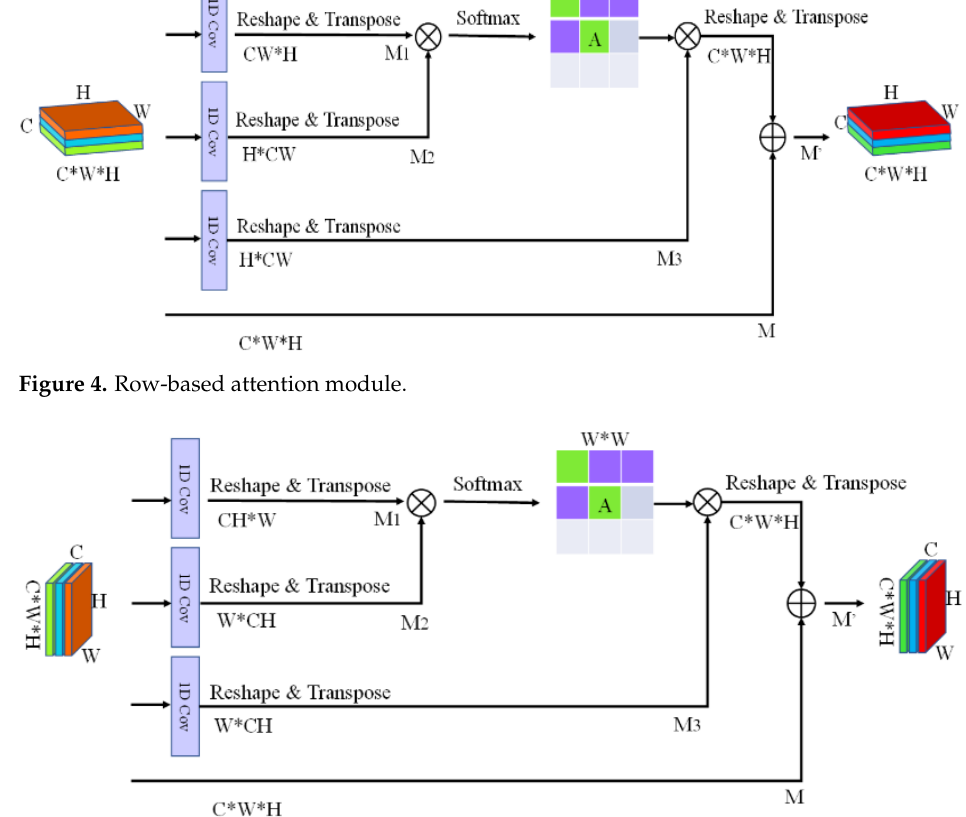
Figure 5. Column-based attention module.